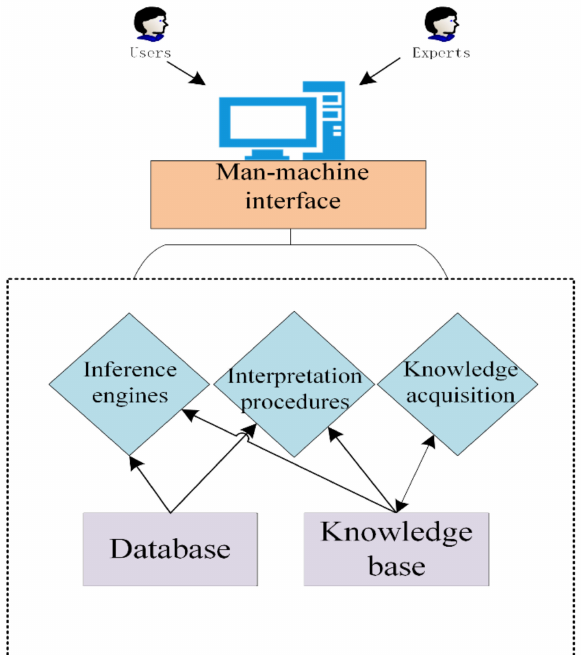
Figure 4. Illustration of the structure of the expert system and the flow of